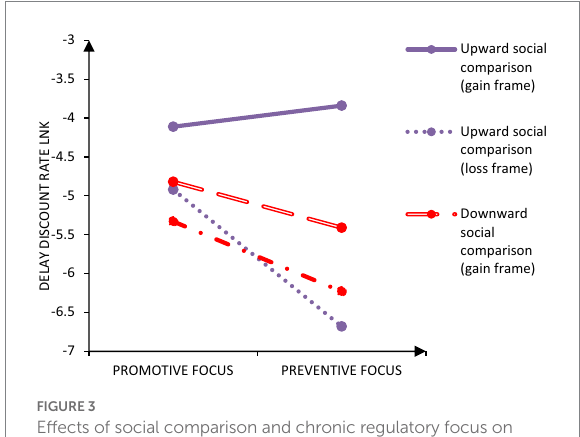
FIGURE 3 Effects of social comparison and chronic regulatory focus on intertemporal decision making in the gain-loss